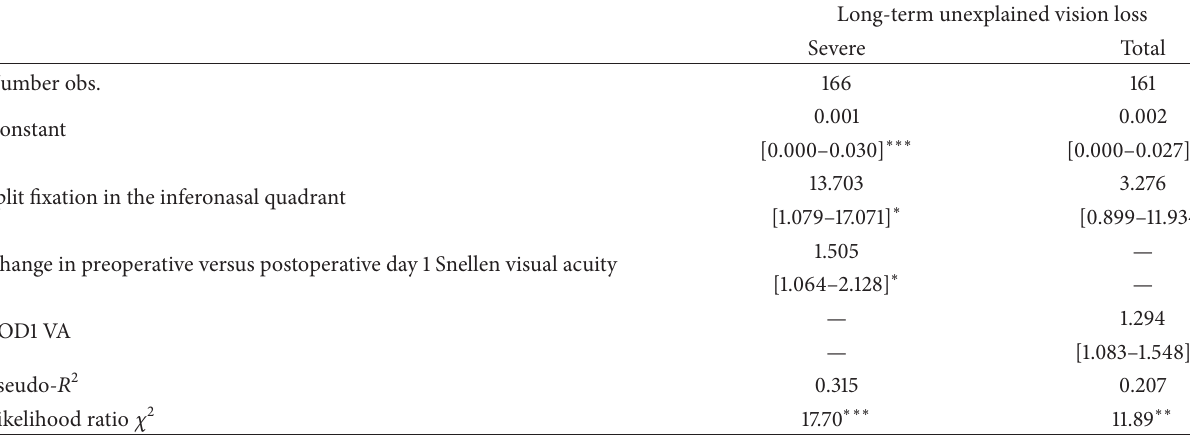
Long-term unexplained vision loss Severe Total